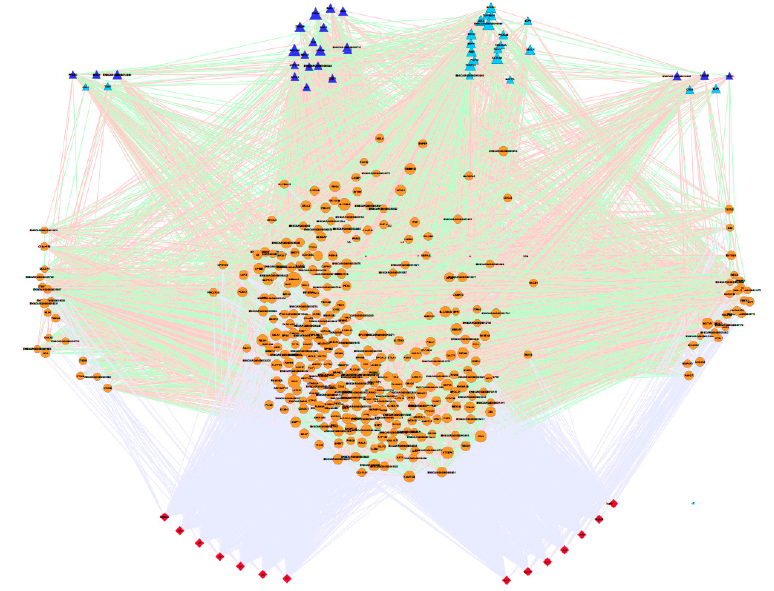
Figure 4. Co-association network between the 374 genes selected by the stepwise procedure. This network includes all the transcription (TF: depicted in dark blue) and co-transcription factors (CF: described in light blue) and the rest of genes (painted in orange), together with the 14 traits analysed (depicted in red). The significant co-associations between the pair of genes and the significant association between a gene and a trait were represented with an edge (Positive co-associations: green, Negative co-associations: red; GWAS association: grey). The size of the nodes was based on the pleiotropic effect of the gene on the traits under study. This co-association network explained a total of 76% of the genetic variance.